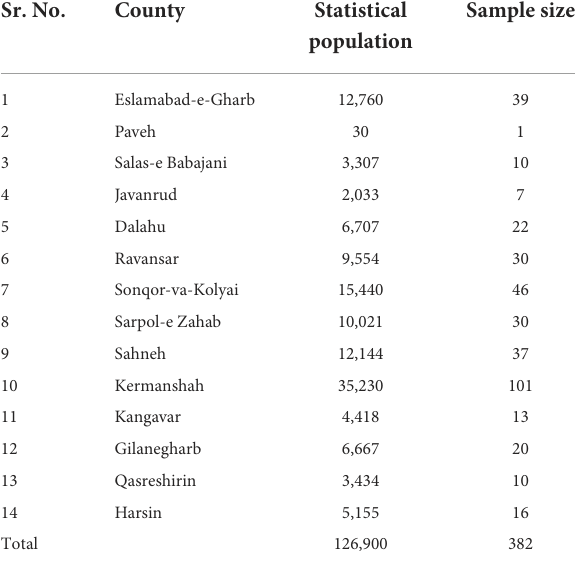
TABLE 2 The exploratory factor analysis of farmers’ vulnerability to COVID-19.